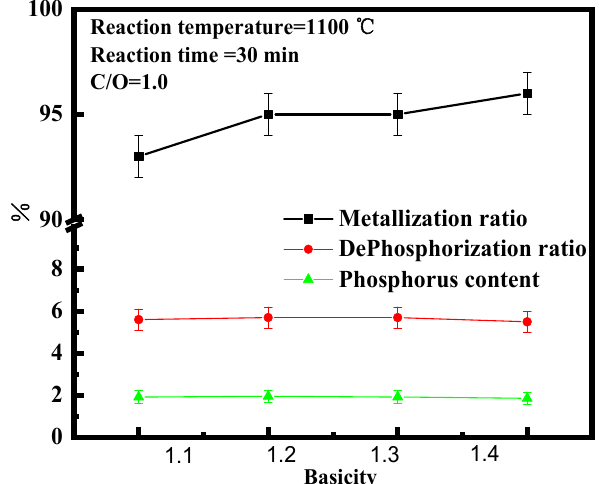
Figure 6. The effects of basicity on the metallization ratio, dephosphorization ratio, and phosphorus content of pellets.